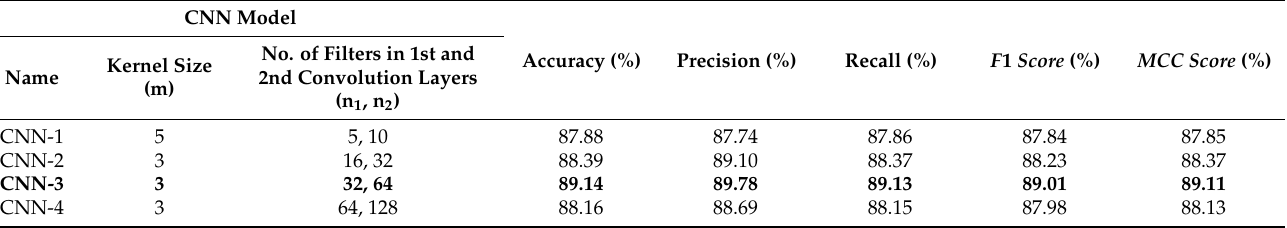
Table 4. Effect of kernel size and filter numbers on CNN model performance for classifying 100 se- quences per species dataset with 4-mer features. Highest values are highlighted in bold.